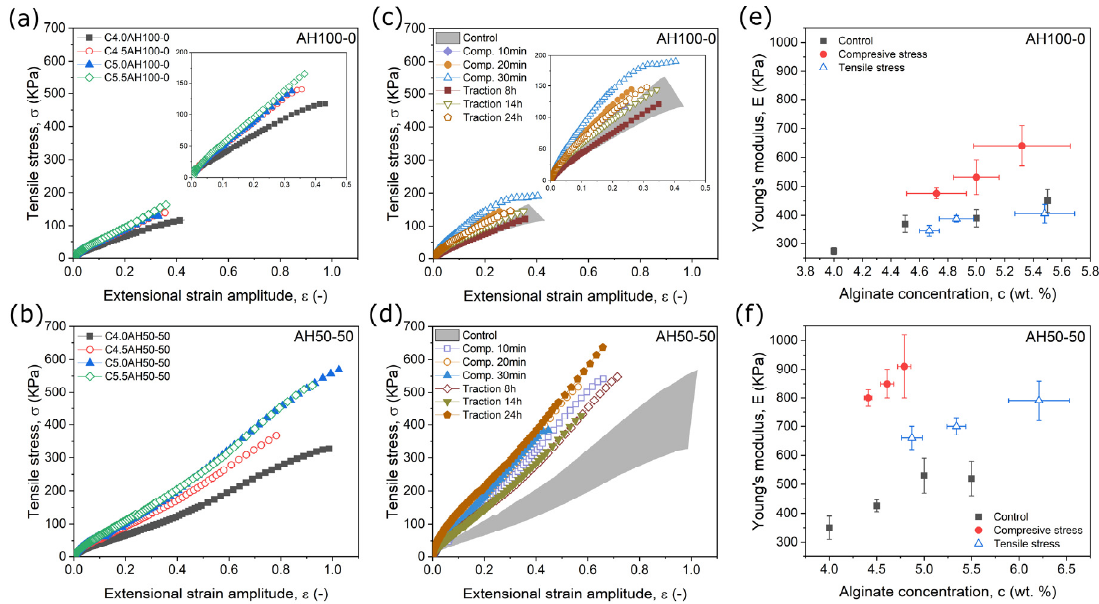
Figure 1. Results from uniaxial tensile characterization. From ( a – d ) strains vs. stress example curves for the different samples studied. ( a , b ) control samples of the two types of alginate hydrogels studied, the insets are the same data with a different scale. ( c , e ) strains vs. stress curves for each SCDP. Shaded bands represents the range of values for control samples. In ( e , f ) the values of Young’s modulus for each SCDPs and alginate concentration obtained after the dehydration are shown, as well as the values for control samples. Note that same scales are used in both